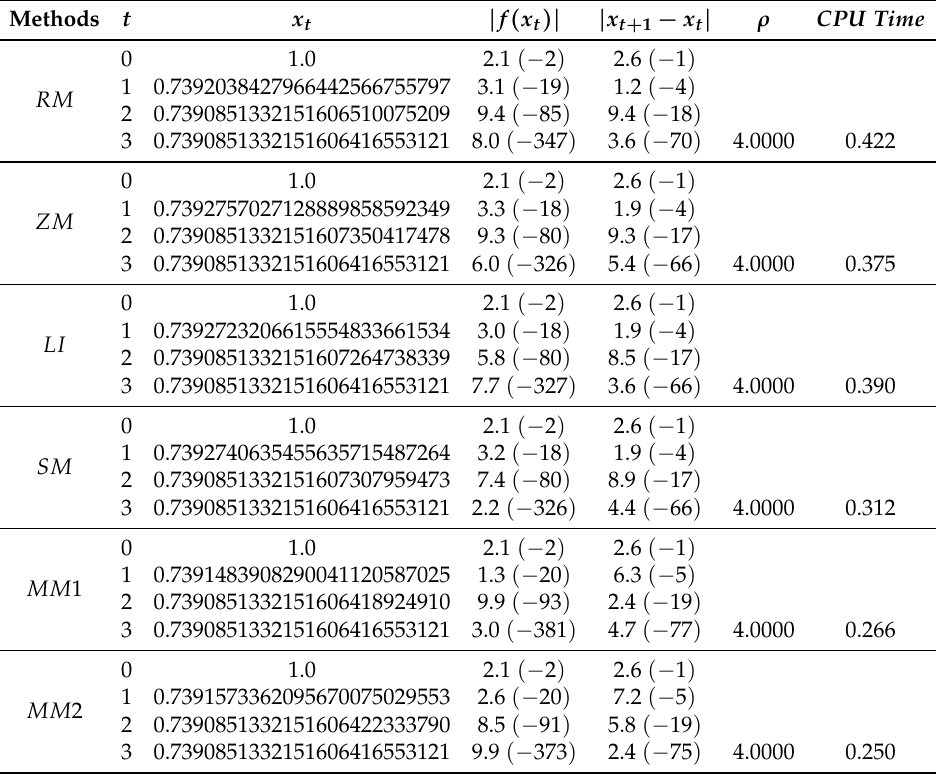
Table 6. Outcomes for comparison by testing schemes on Example